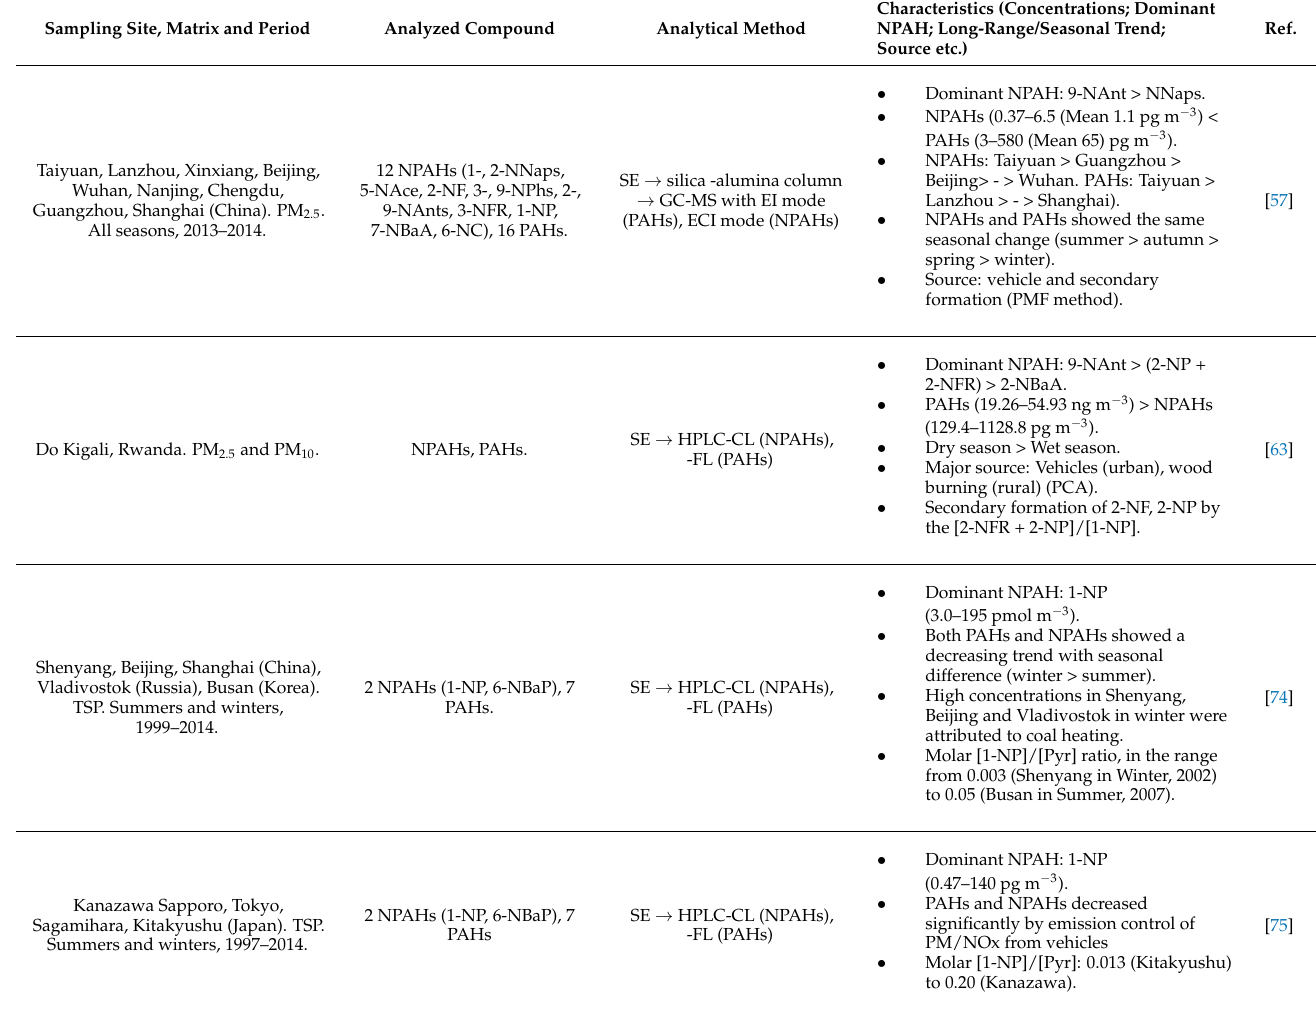
Table 3. Typical papers on environmental NPAHs in the world. Sampling Site, Matrix and Period Analyzed Compound Analytical Method